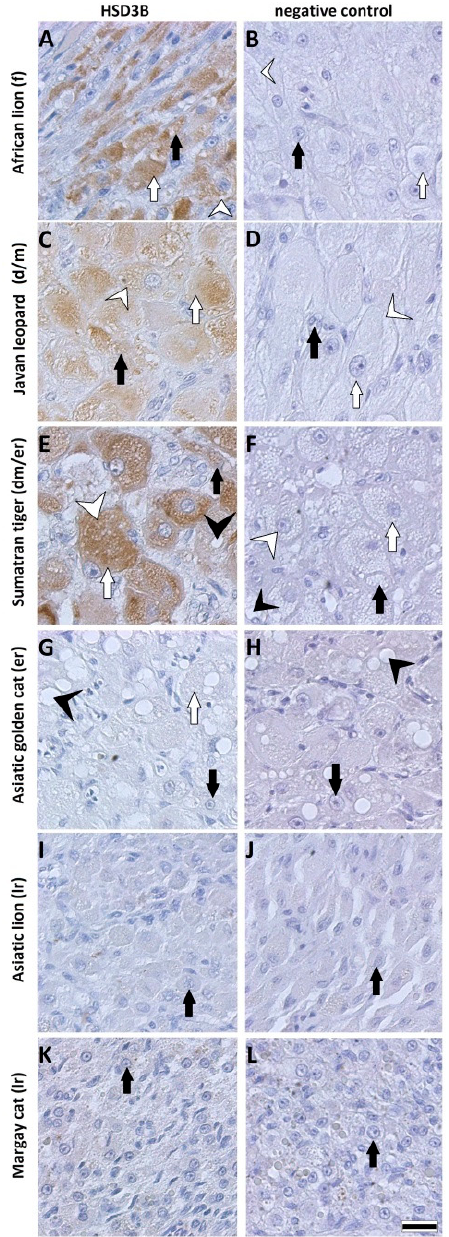
Figure 5. Immunohistochemical staining for HSD3B and negative control in CL from the African lion ( A , B ), Javan leopard ( C , D ), Sumatran tiger ( E , F ), Asiatic golden cat ( G , H ) Asiatic lion ( I , J ) and Margay cat ( K , L ). HSD3B protein signal was detected in a cytoplasm of SLC and LLC. f— formation, dm—development/maintenance, er—early regression, lr—late regression. Scale bar is equal to 20 µ